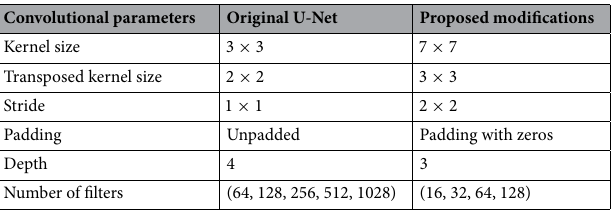
Table 1. Convolutional parameters of the original U-Net and proposed modifications.